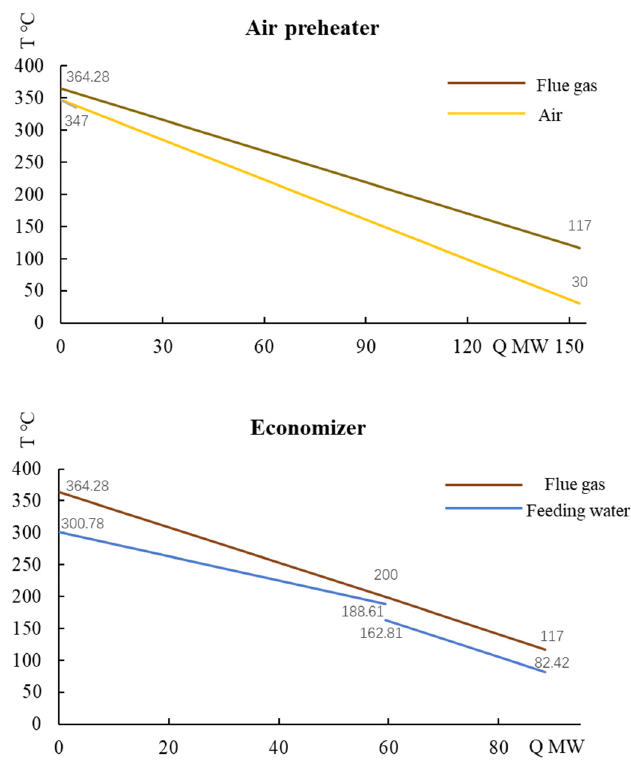
Figure 8. Heat transfer analysis of the tail flue in new system 1.